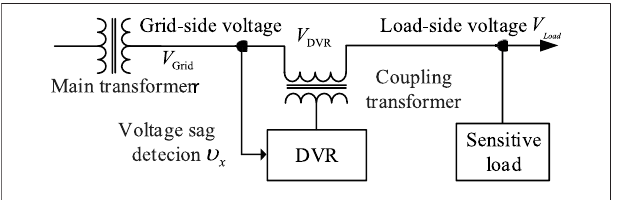
FIGURE 1 | Voltage sag compensation of the